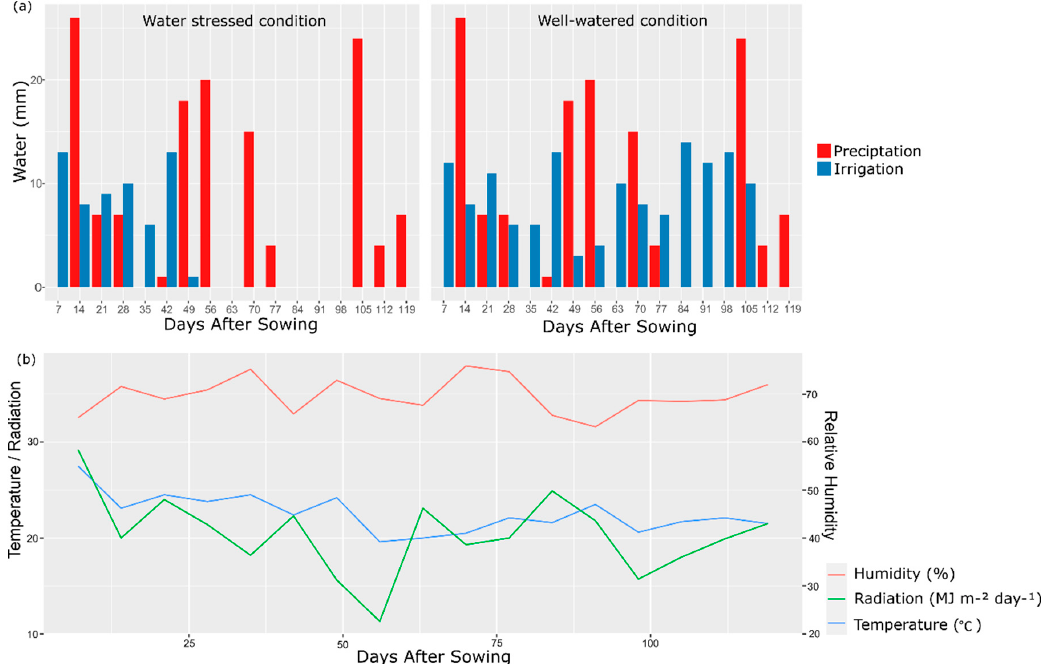
Figure 1. ( a ) Precipitation occurs during a trial conducted with 20 popcorn lines under well-watered condition and water-stressed condition. ( b ) Humidity, solar radiation, and temperature values measured in water stressed and well-watered conditions.